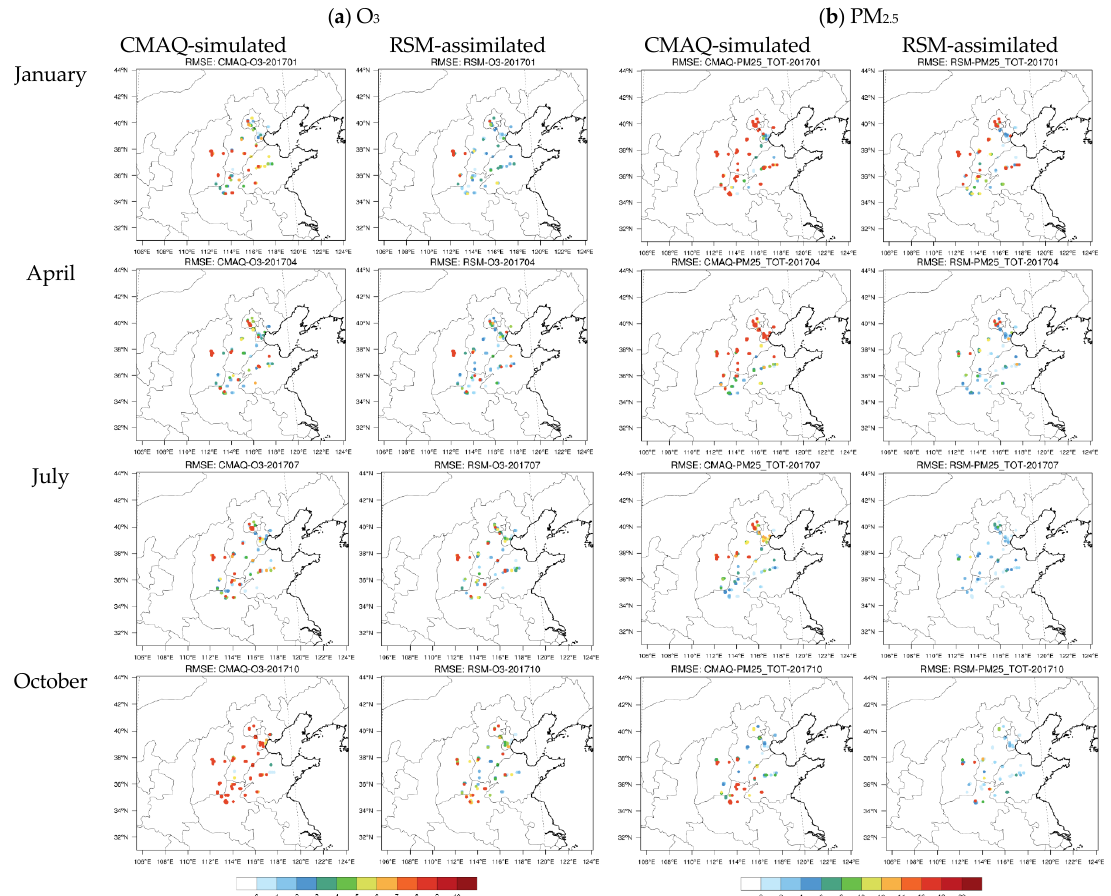
Figure 5. Comparisons of RMSE in CMAQ-simulated and RSM-assimilated concentrations of O 3 (a; unit-ppb) and PM 2.5 (b; unit-μg·m −3 ) across all observation sites unit-ppb) and PM 2.5 (b; unit- µ g · m − 3 ) across all observation